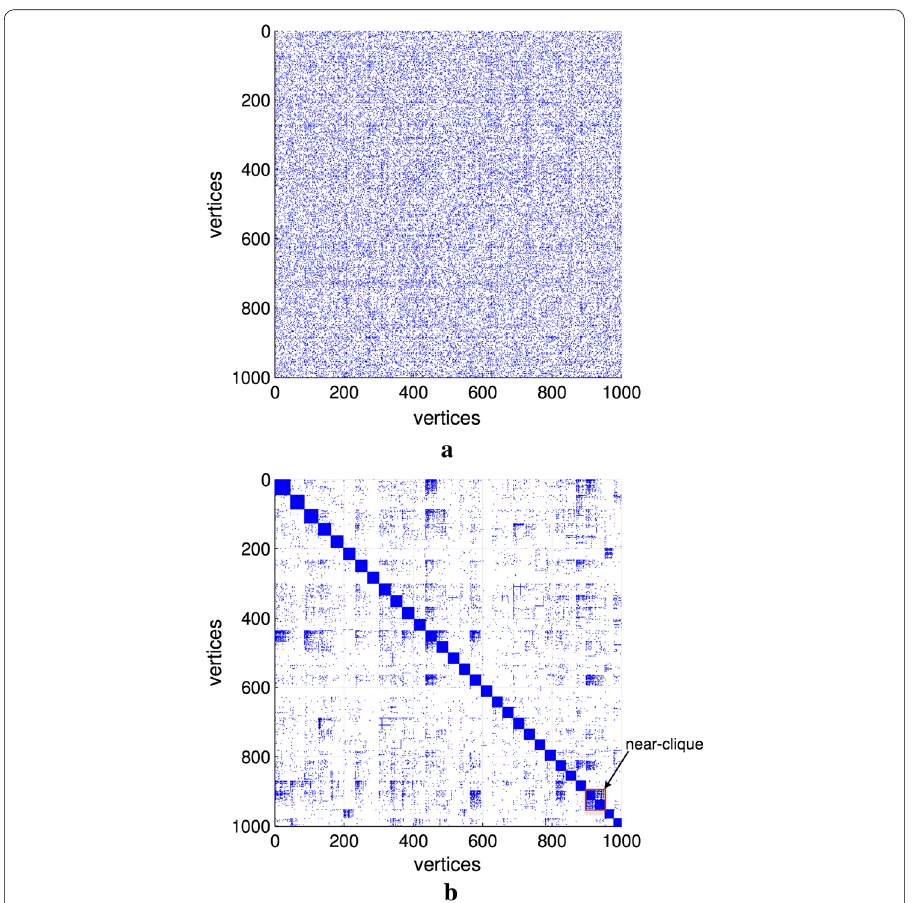
Fig. 6 Clique ordering is shown on the right compared to the initial ordering on the left. The dense off diagonal blocks reveal large cliques along the diagonal that are tightly connected and form much larger near-cliques . a Initial ordering. b Clique